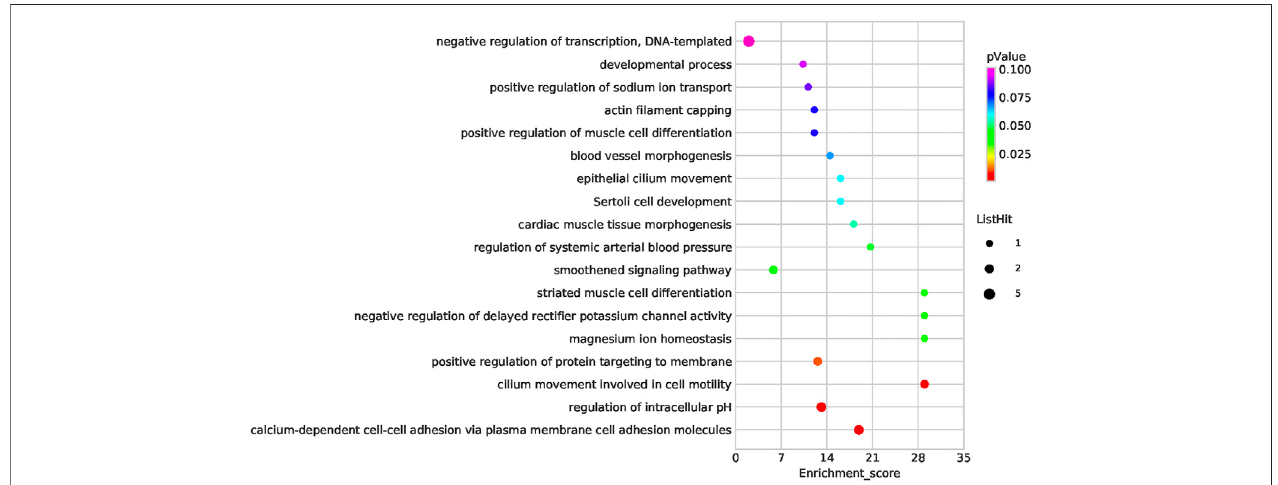
FIGURE 5 | Bubble plot of the GO analysis. Bubble plot summarizing enrichment for the most signi fi cant biological process GO terms associated to differentially expressed genes. The bubble size indicates the frequency of the GO term, while the color indicates the p -value.